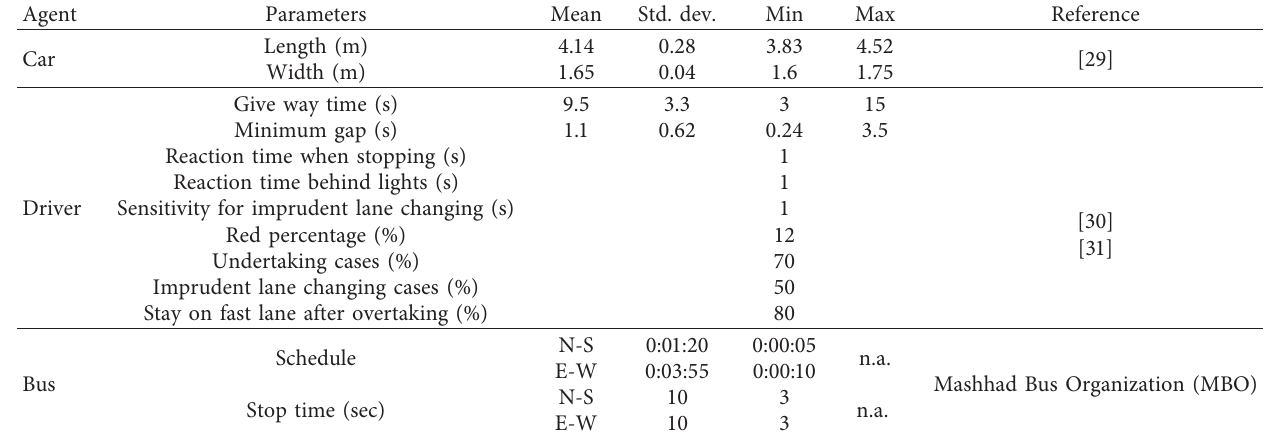
Figure 3: The aerial image of Basij throughabout and geometry of proposed designs in AIMSUN. (a) The aerial image of the Basij roundabout. (b) The throughabout. (c) The standard roundabout. (d) The conventional intersection. Table 4: The inputs calibrated in the AIMSUN software for the roundabouts of